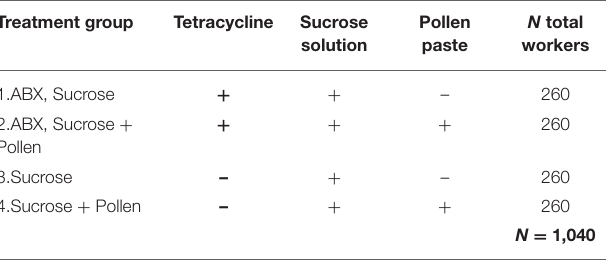
TABLE 1 | Overview of the fully-crossed experimental set-up. Treatment group